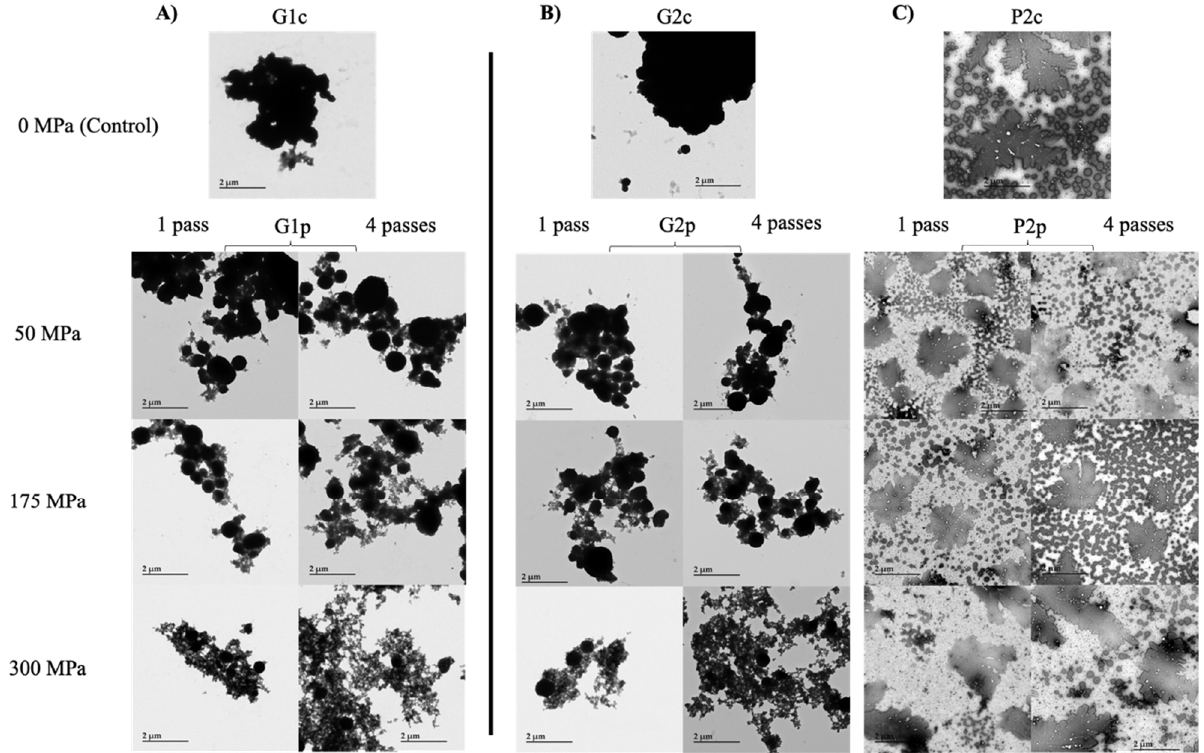
Figure 4. Microstructures of ( A ) initial control granule (G1c) and pressure-treated granule (G1p), ( B ) control granule from initial control granule (G2c) and granule from pressure-treated granule (G2p), and ( C ) control plasma from initial control granule (P2c) and plasma from pressure-treated granule (P2p) observed by transmission electron microscopy with a magnification of 3K.